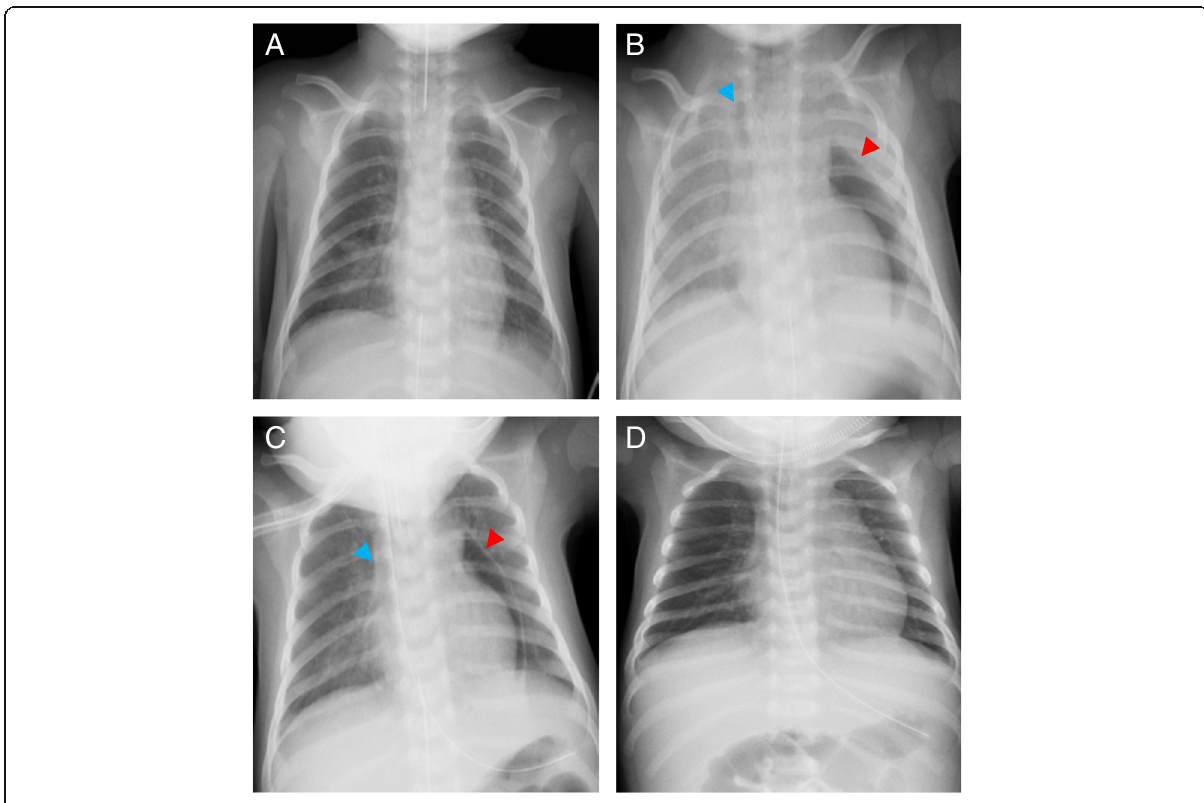
Fig. 1 Chest X-rays in the operating room and in the intensive care unit. a Right after the pericardiocentesis, b before re-intubation approximately 2.5 h after admission to the ICU, c 10 min after re-intubation, and d after the drainage tube was removed. The red and blue arrows indicate pneumopericardium and pneumomediastinum,